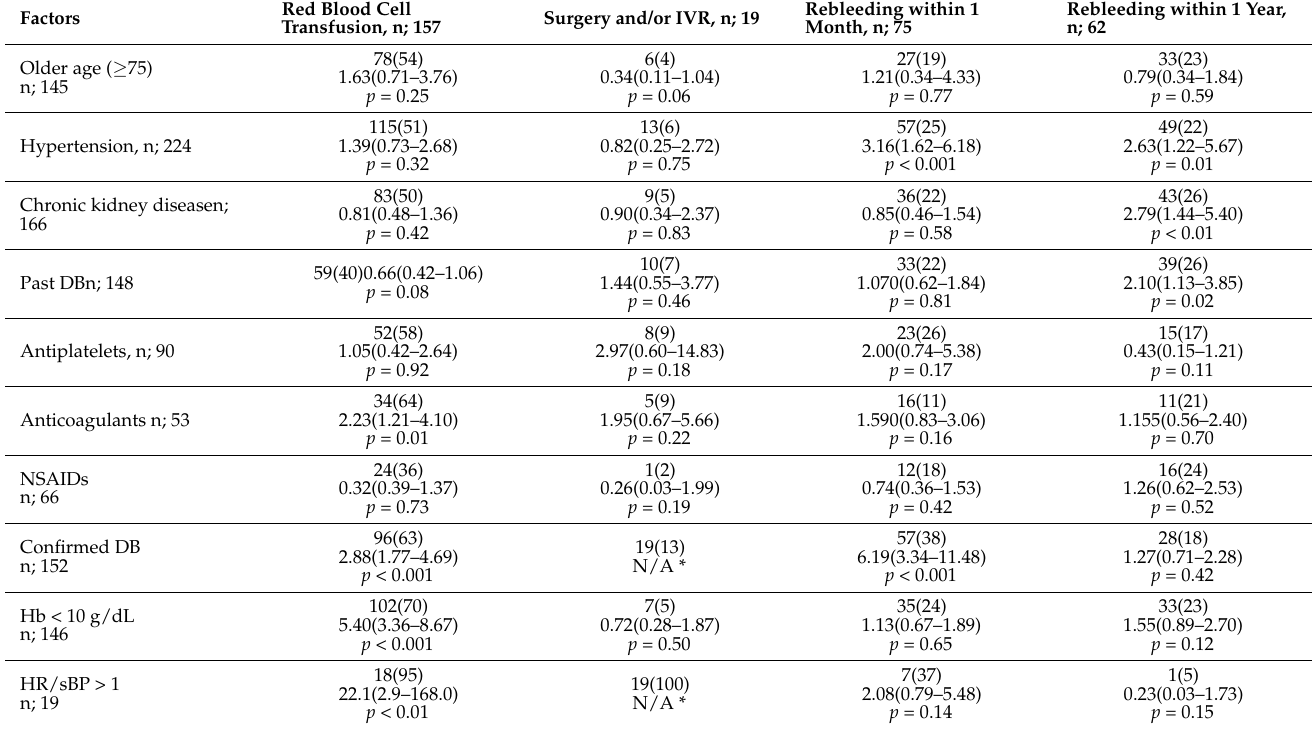
Table 2. Impact of clinical factors on blood transfusion, invasive treatment, and rebleeding in patients with diverticular